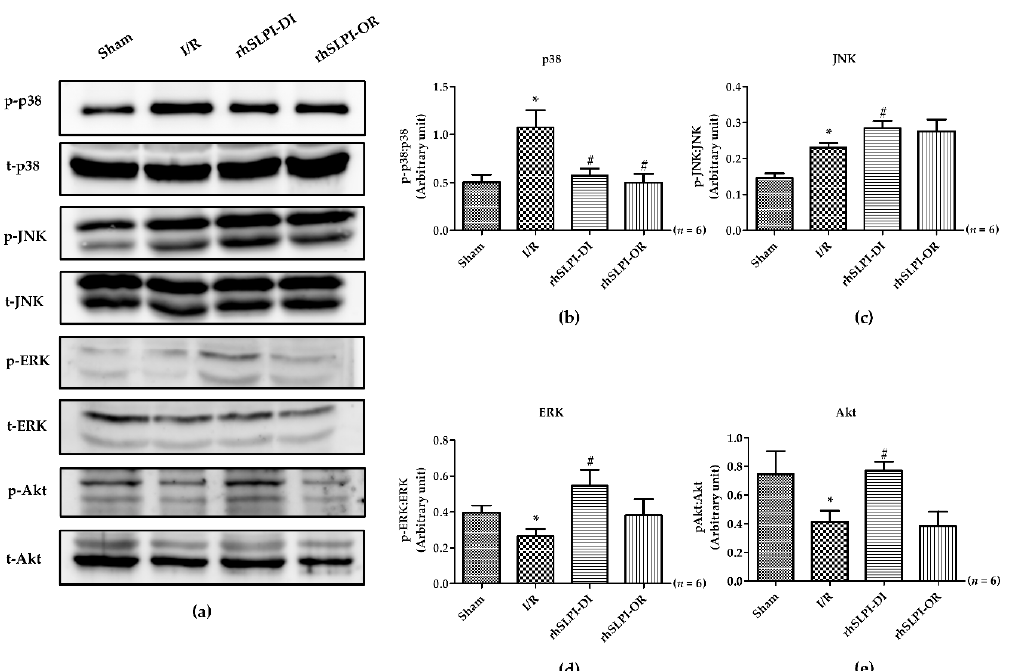
Figure 6. Determination of rhSLPI on activation of MAPK kinase involved in cell injury and survival in MI rat by Western blot analysis ( a ). The quantitative analysis for the MAPK phosphorylation was presented for p38 ( b ), JNK ( c ), ERK ( d ) and Akt ( e ). (* p < 0.05 vs. sham) ( # p < 0.05 vs. I/R) ( n = 6).